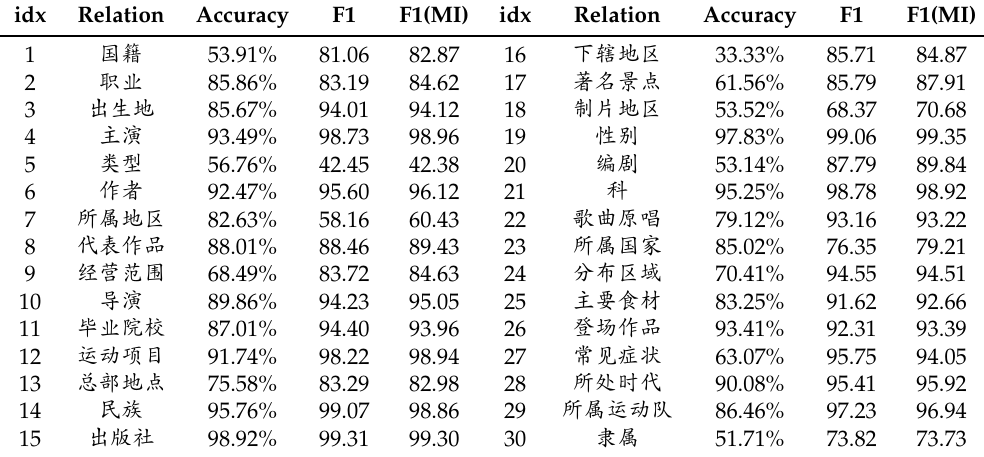
Table 5. F1 score of each relation using proposed model in word